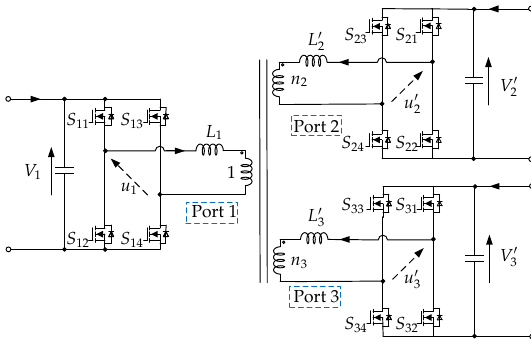
Figure 2. Triple-active-bridge (TAB) converter circuit.